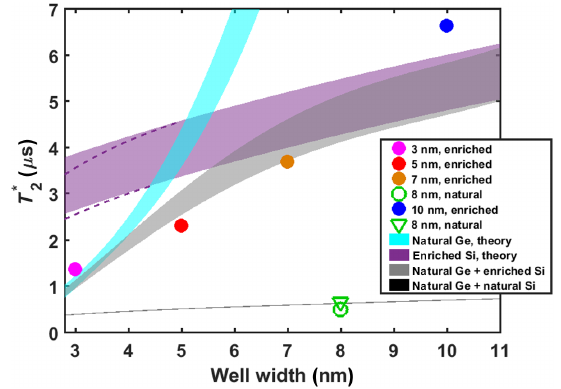
FIG. 6. The T ∗ values measured at a few millitesla for the 2 same devices as in Fig. 5. The two devices with natural isotopic values of 0.51 and 0.66 μ s. The colored bands Si content have T ∗ 2 defined show the μ ± 2 σ range, where μ is the mean value of T ∗ 2 for each nuclear species and σ is the standard deviation under random isotopic placement, calculated from Eq. (10). The pur- ple band shows the anticipated contribution of 29 Si, while the cyan band shows the contribution of 73 Ge, which dominates the amount of variation with well width. The gray band is the total of natural Ge and enriched Si material. The final anticipated T ∗ 2 “natural Ge + natural Si” band is similarly the range of expected values for this material, although the distribution is so tight T ∗ 2 that it is rendered as a line here. The purple dashed lines show due to isotopically natural Si (relative the small reduction of T ∗ 2 to 800 ppm 29 Si) in the barriers; this reduction is negligible in comparison to the wells for wide well widths and in comparison to the Ge contribution for narrow well